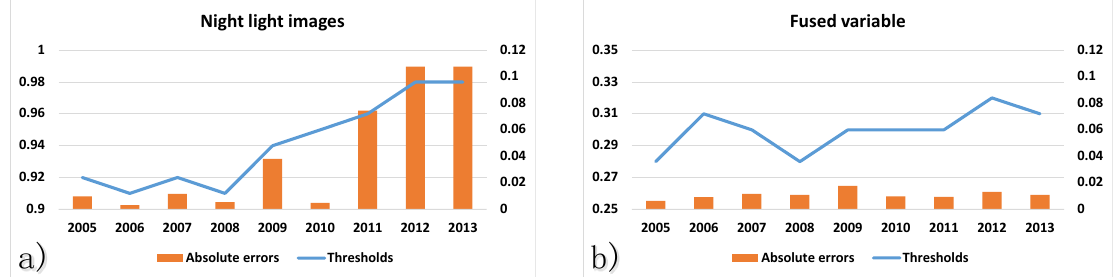
Figure 6. Optimal thresholds and the related absolute errors for 9 years. ( a ) By the only night light images and ( b ) by the fused variable NUBAI. The thresholds are related to the primary axis (left) and the accuracies are related to the secondary axis (right). To compare the degree of the stability of both variables, we set the same length to the axis ranges in two figures, namely 0.9–1 and 0.25–0.35. To compare the extraction effect (absolute error), all the values of the secondary axis are set to the same in two figures.